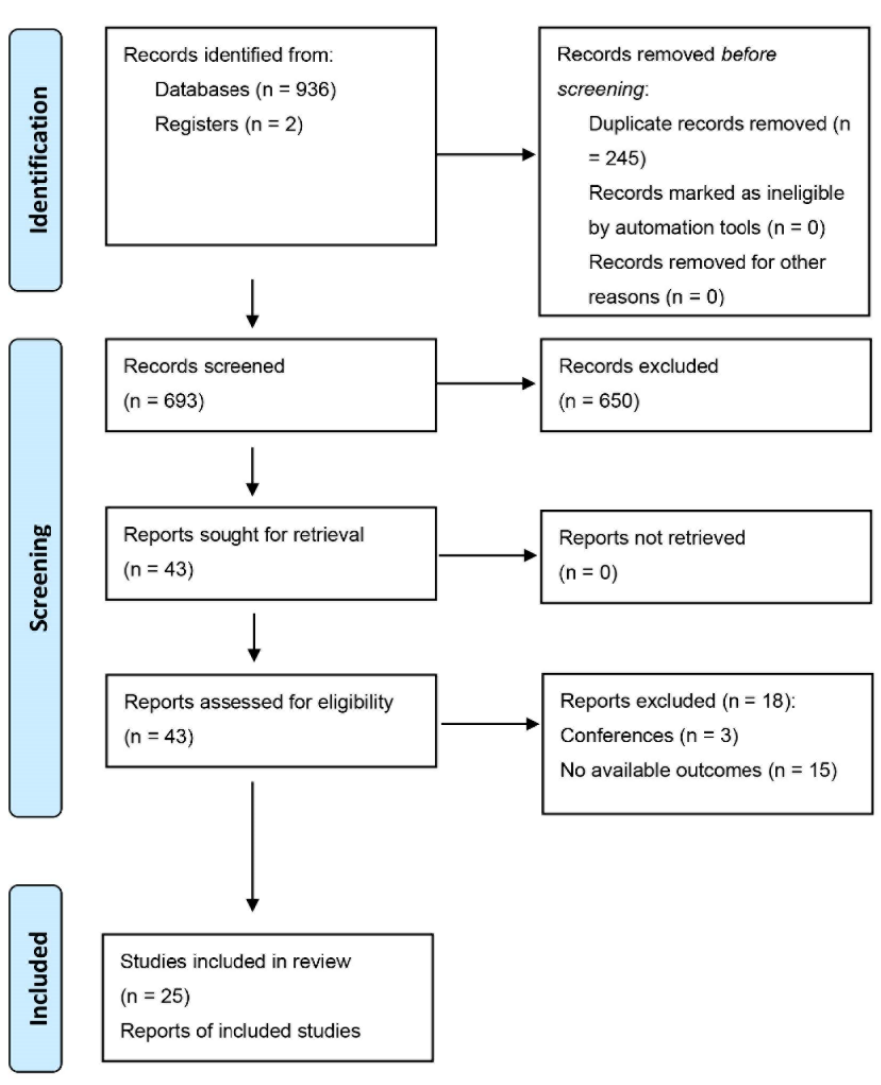
Figure 1. The literature retrieval and screening process according to the PRISMA guidelines.